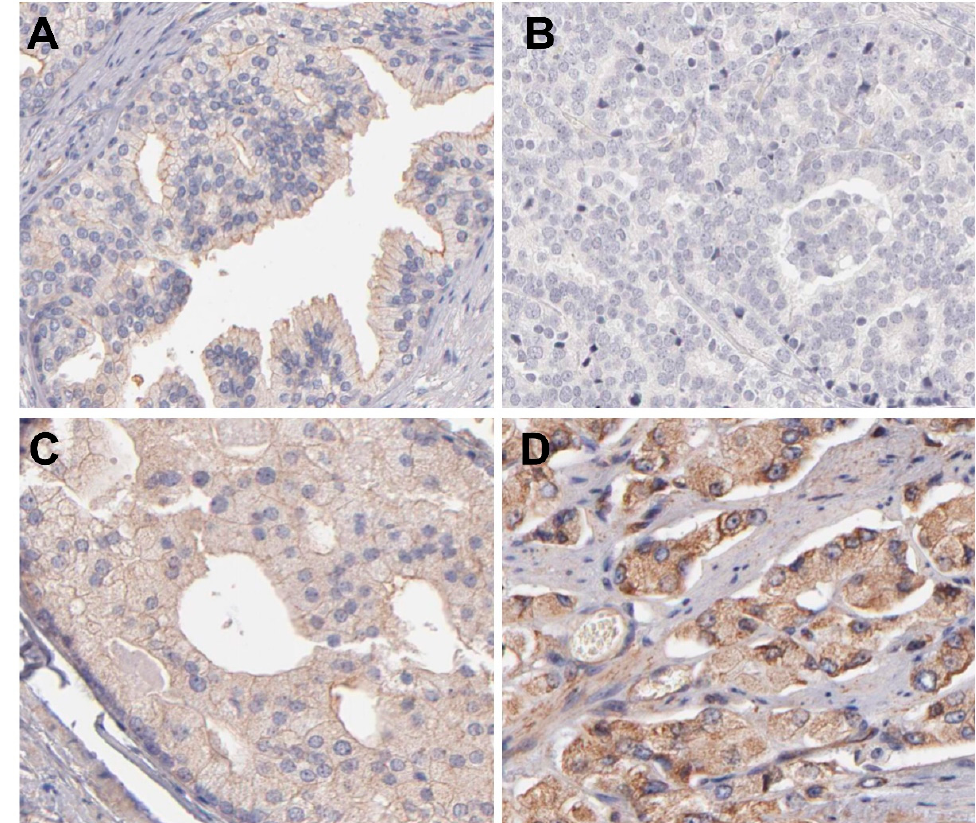
Figure 5. P-glycoprotein (P-gp) immunohistochemical expression human prostatic samples. ( A ): Normal prostate gland showing weak membranous P-gp expression by luminal cells. ( B ): A high-grade prostate cancer (PC) showing no P-gp expression. ( C ): A PC representing moderate cytoplasmic and membranous P-gp expression. ( D ): A high-grade PC showing strong membranous and cytoplasmic P-gp expression. Image credit of the IHC images: Human Protein Atlas, www.proteinatlas.org. Image available at the following URL: https://www.proteinatlas.org/ENSG00000085563-ABCB1 /pathology/prostate+cancer#img, accessed on 16 November